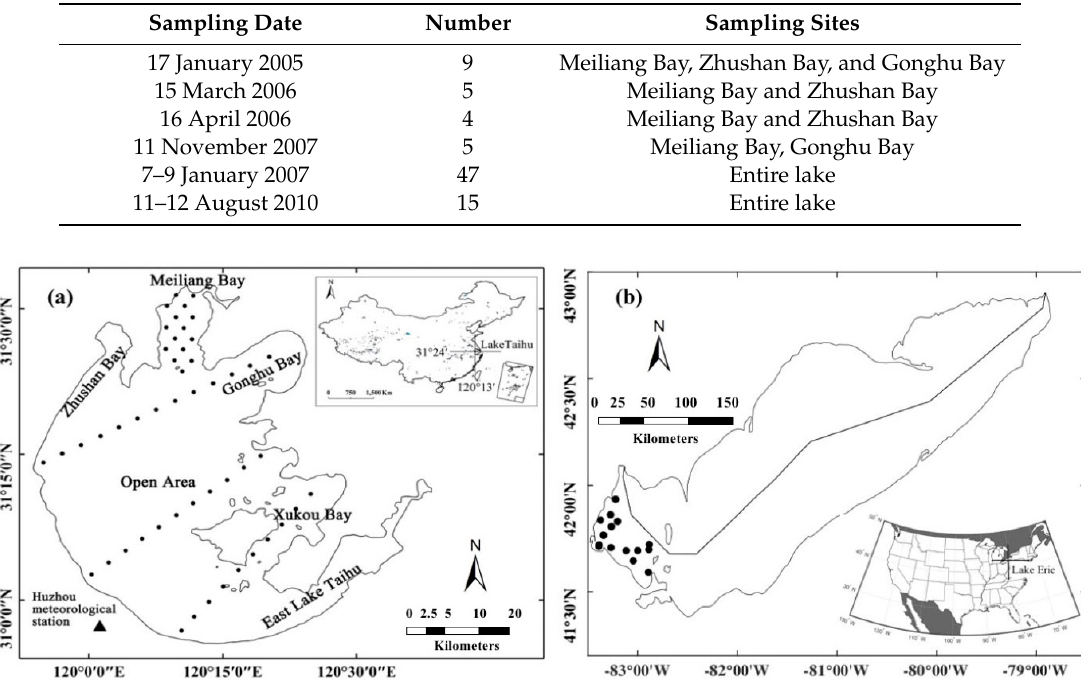
Figure 1. Station maps of datasets Lake Taihu ( a ) and Lake Erie ( b ).